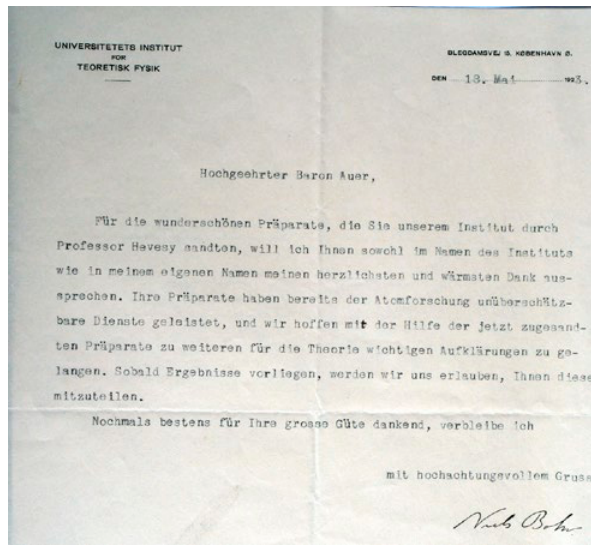
Figure 4. Niels Bohr to Carl Auer von Welsbach (05/13/1923). Source: Archives Auer-von-Welsbach Research Institute, File: Cor- respondence; Location: Auer-von-Welsbach Museum, Althofen